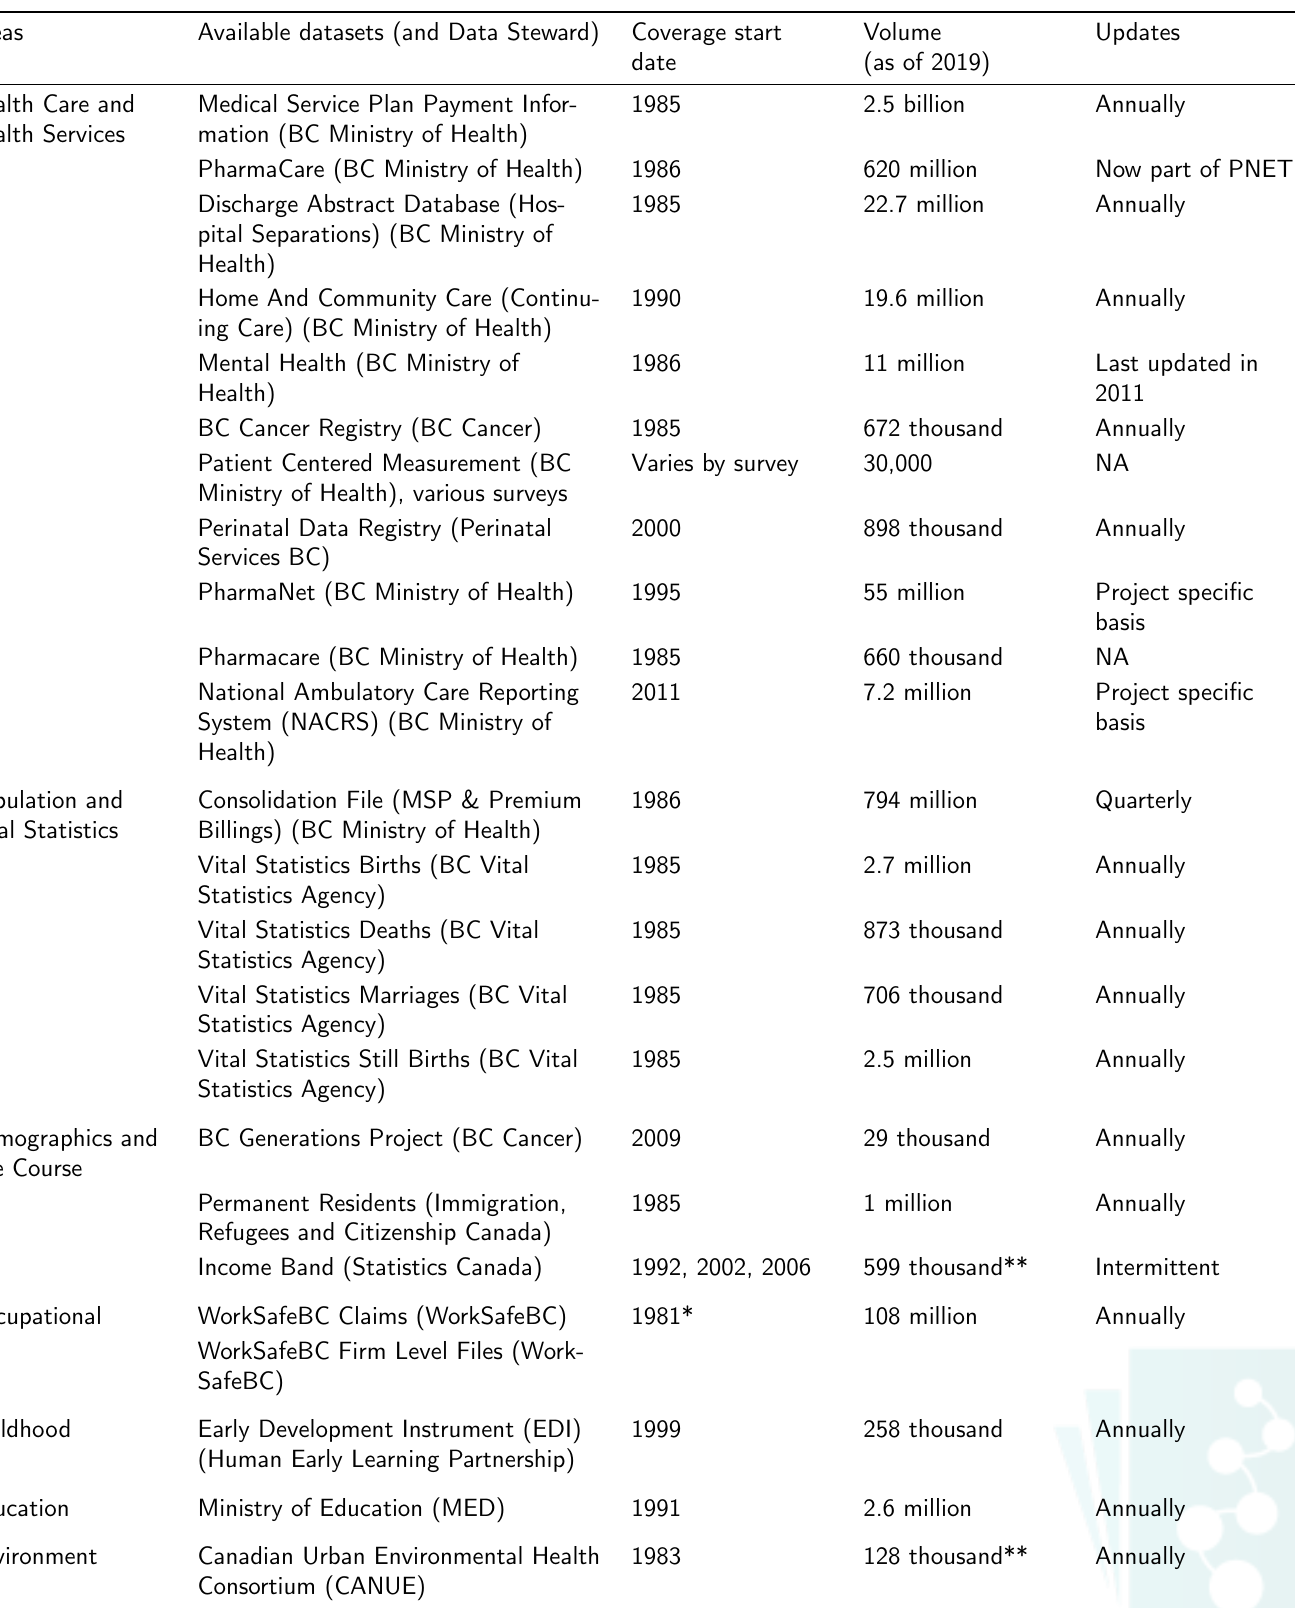
Table 1: Measures and characteristics available in the pseudonymised Cafcass data